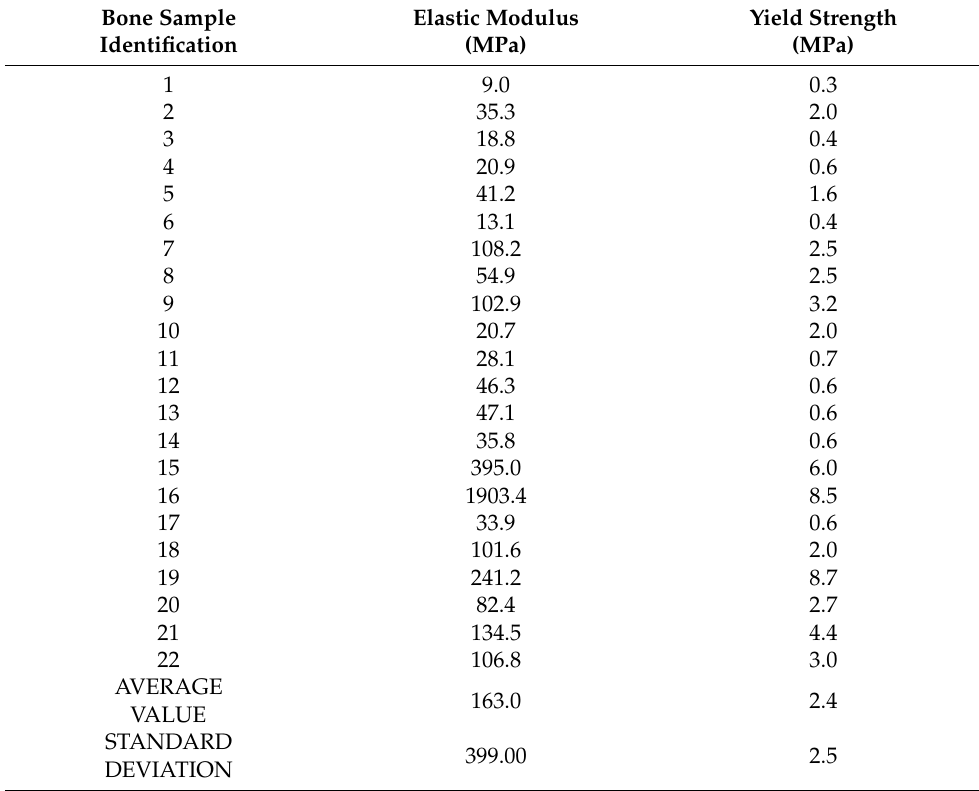
Table 3. Compression testing results of the trabecular bone specimens of the second